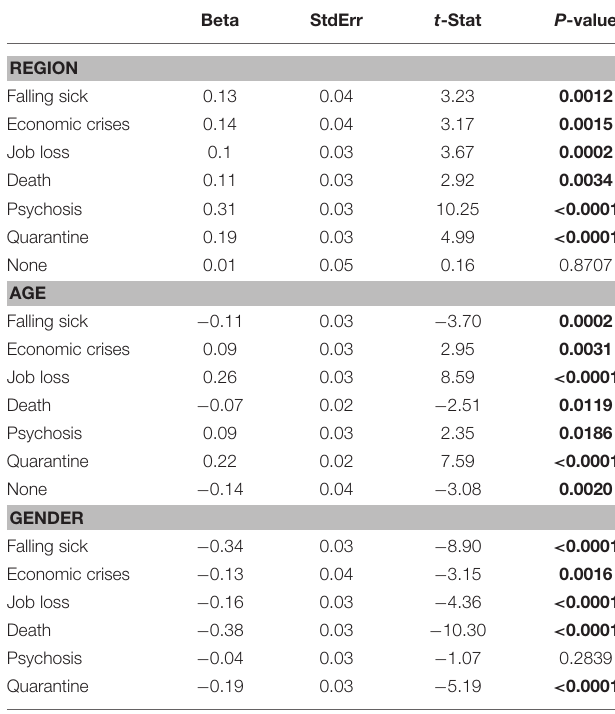
TABLE 4 | Multinomial logistic regression data for frightening events category and demographic factors (region, age, and gender).